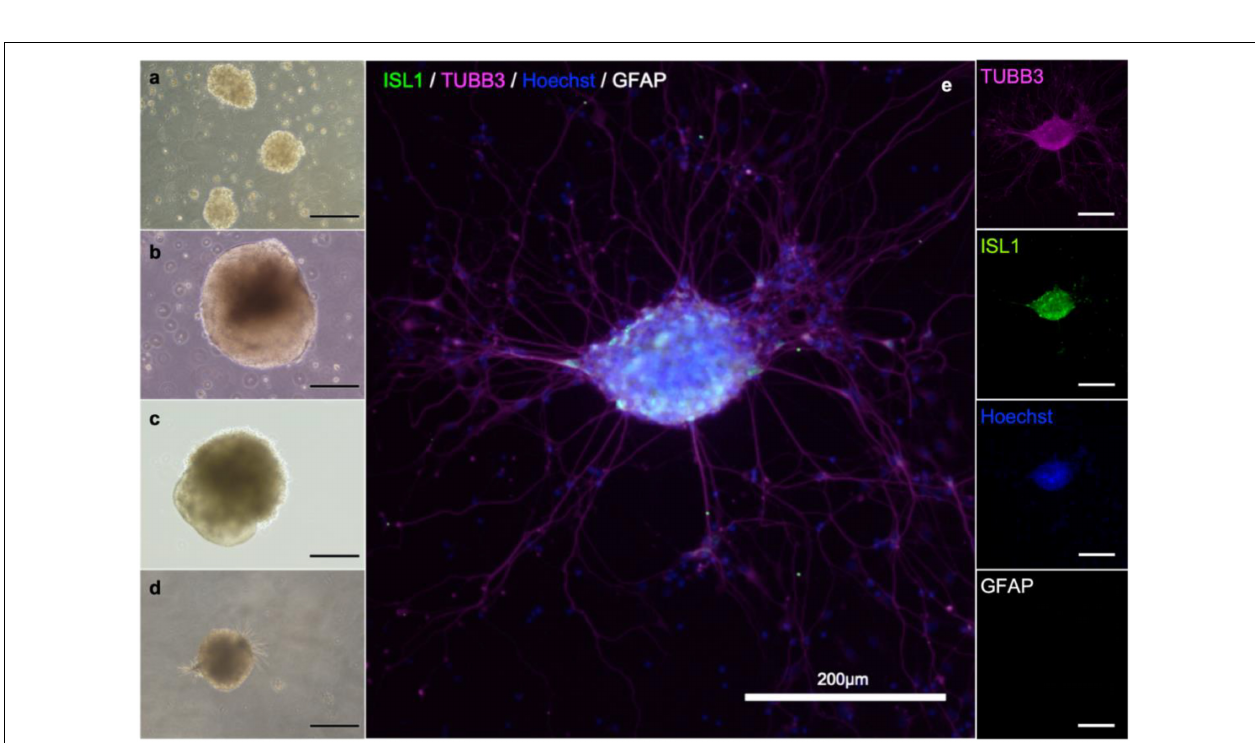
FIGURE 3 | MN aggregate derived from iPS cell reprogramming. Cells during differentiation, corresponding to day 2 (a) , 9 (b) , 18 (c) and 25 (d) . After 21 days, MNs are present in the population. Neuronal aggregates (e) were formed after dissociation at day 30 and post-seeding and maturation for another 9 days. Immunostaining of the aggregates reveals the presence of immature neurons ( β -III-tubulin; magenta), motor neurons (Islet 1; green), and in this batch no astrocytes (GFAP; gray). Nuclear counterstaining with Hoechst (blue).